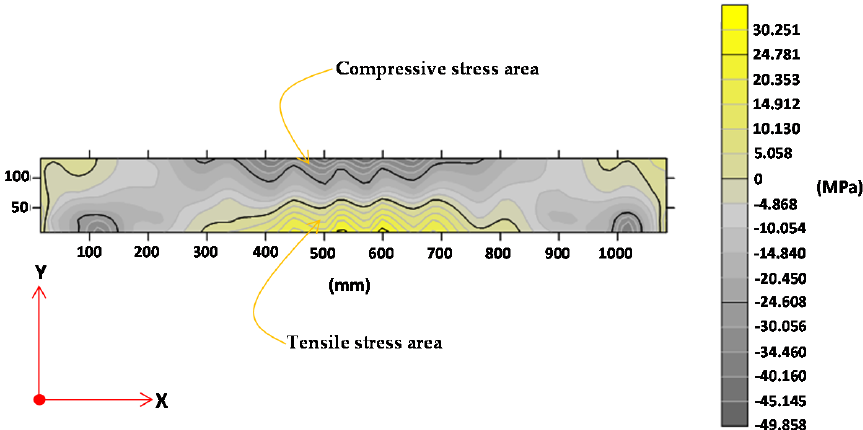
Figure 18. The stress contour of X-direction of SRC beam.